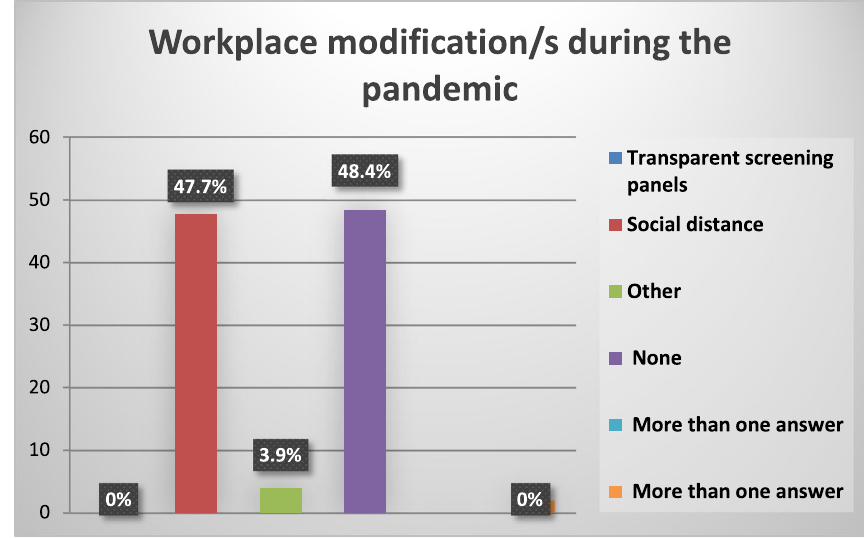
Fig. 5 The workplace modifications during the pandemic